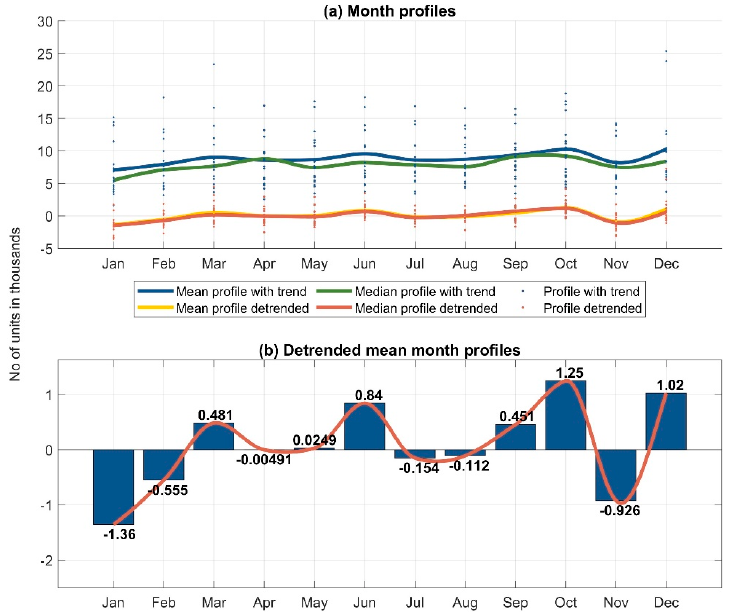
Figure 3. Averaged annual profile. Permits issued for construction—sale or rental (Source: own compilation based on data from CSO).